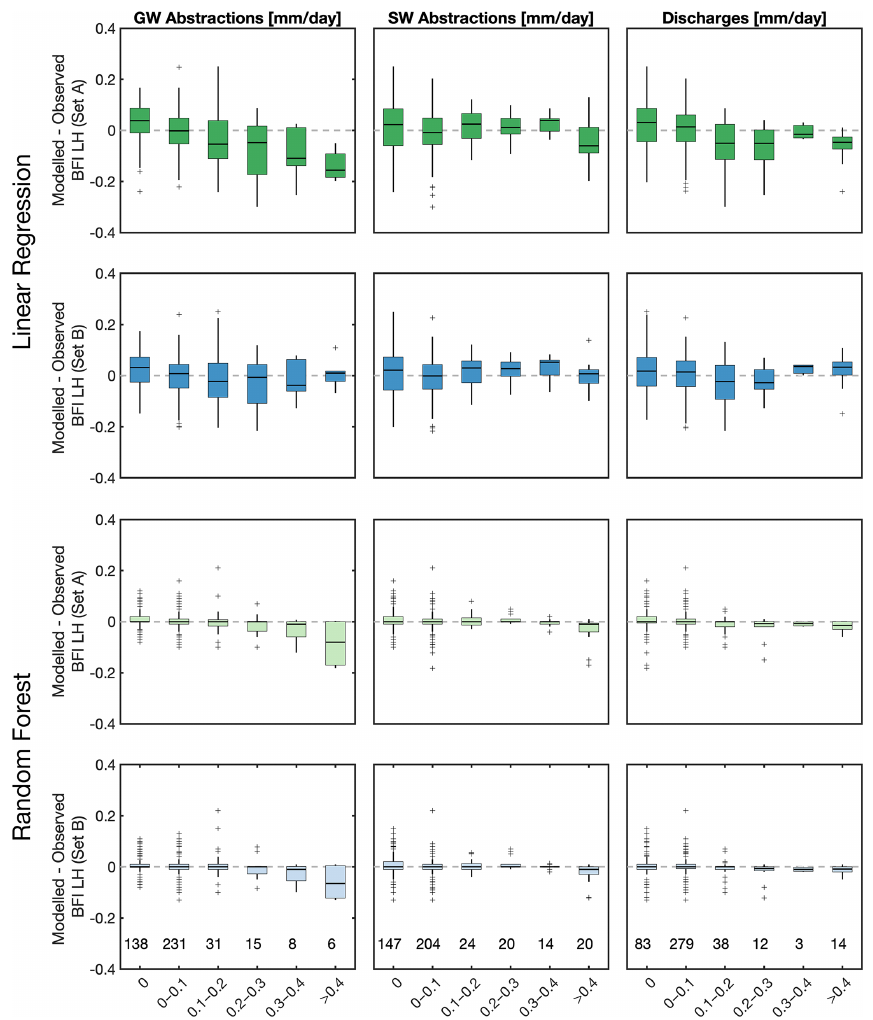
Figure 8. Comparison of observed and modelled BFI_LH for covariate Sets A and B, for LR and RF models and as a function of different human management